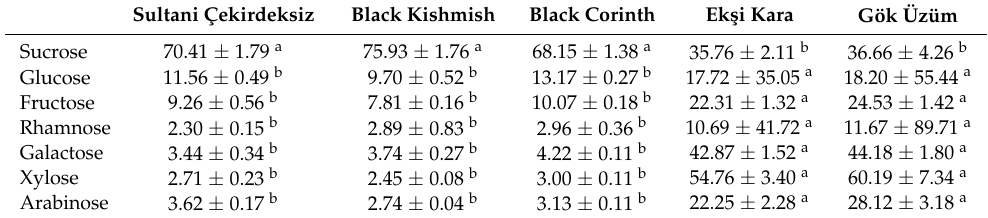
Table 3. Sugar contents (g 100 g − 1 ) of two stenospermocarpy varieties (Sultani Çekirdeksiz and Black Kishmish); one parthenocarpic variety (Black Corinth), and two seeded varieties (Ek¸si Kara and Gök Üzüm) in 2020